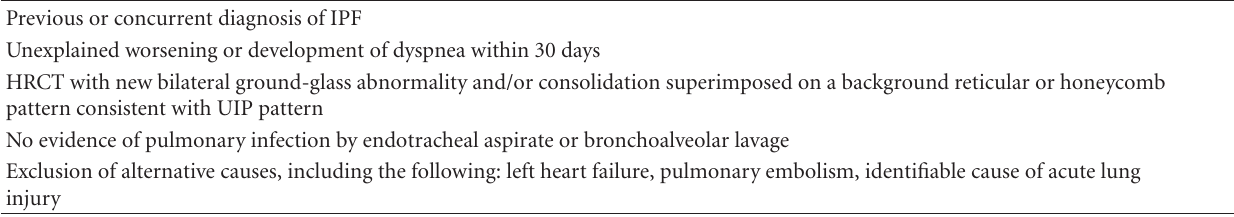
Table 3: Proposed criteria of AE of IPF by Collard and the IPF Clinical Research Network Invertigators [34]. Previous or concurrent diagnosis of